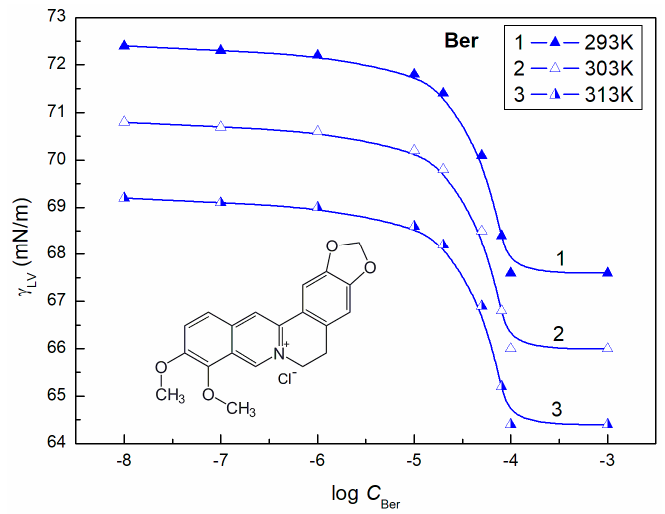
Figure 1. A plot of the surface tension ( γ LV ) of berberine (Ber) aqueous solutions vs. the logarithm of Ber concentration (log C Ber ) at a constant temperature equal to 293 K (curve 1), 303 K (curve 2), and 313 K (curve 3).